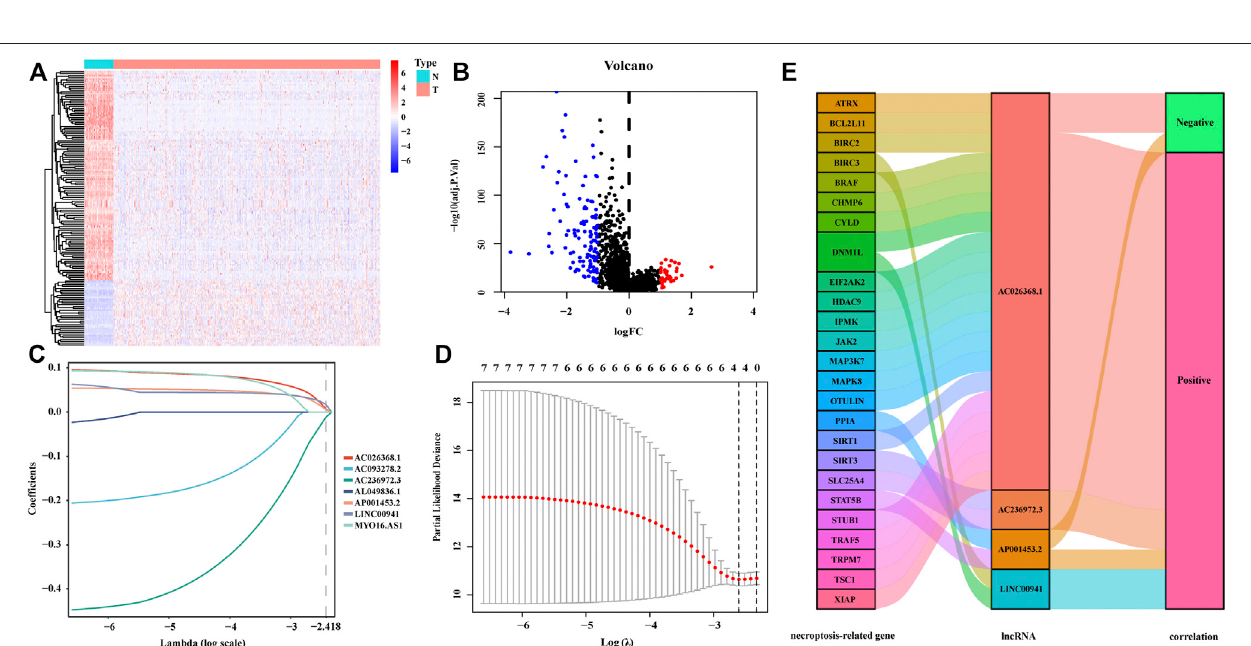
FIGURE2| Constructionofthesignatureincorporatingnecroptosis-relatedlncRNAs.Theheatmap (A) andthevolcanoplot (B) ofdifferentiallyexpressedlncRNAs in LUAD patients. (C,D) The LASSO coef fi cient pro fi les of the 7 lncRNAs at different tuning parameters ( λ ), 10-fold cross-validation to fi ltrate candidate necroptosis- related lncRNAs in LASSO regression analysis. (E) The Sankey diagram of the correlation between necroptosis-related genes (NRGs) and lncRNAs. The left bar representstheNRGs.ThemedianbarrepresentstheselectedlncRNAs.TherightbarrepresentsthecorrelationsbetweenNRGs andlncRNAsgeneratedfromthe Pearson correlation